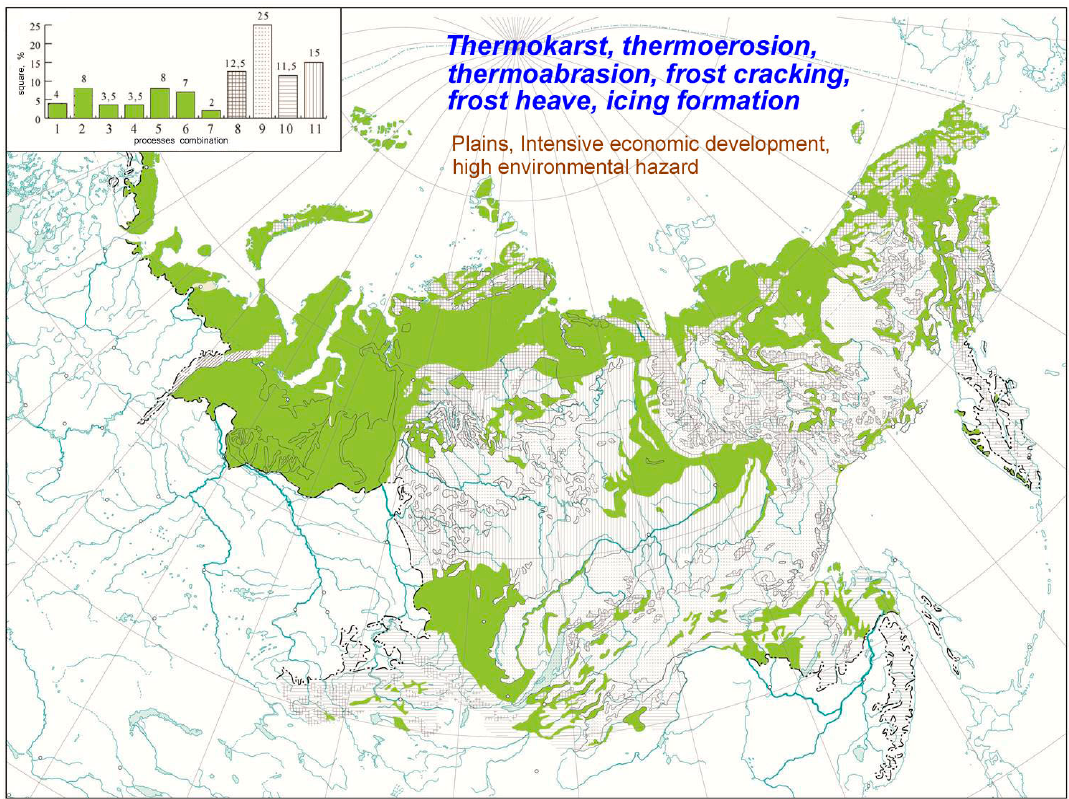
Figure 17. The third group of processes combinations (green color) .